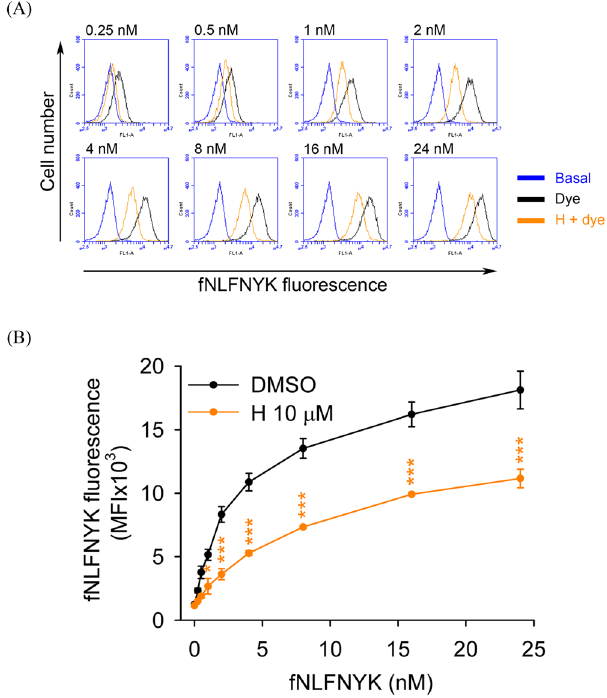
Figure 5. Inhibitory effect of honokiol on dose–response curve of fNLFNYK in human neutrophils. Human neutrophils were incubated with 0.1% DMSO (as control) or honokiol (H; 10 μ M) for 10 min before labelling with different concentrations of fNLFNYK (0.25–24 nM) for 20 min. ( A ) Representative histograms showing typical fluorescence of fNLFNYK in the absence or presence of honokiol. ( B ) Mean fluorescence intensity is shown as the mean ± S.E.M. ( n = 5). * P < 0.05; ** P < 0.01 compared with corresponding